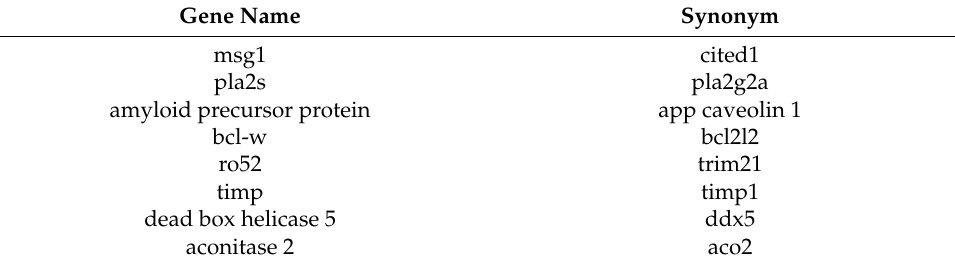
Table 5. Examples of gene